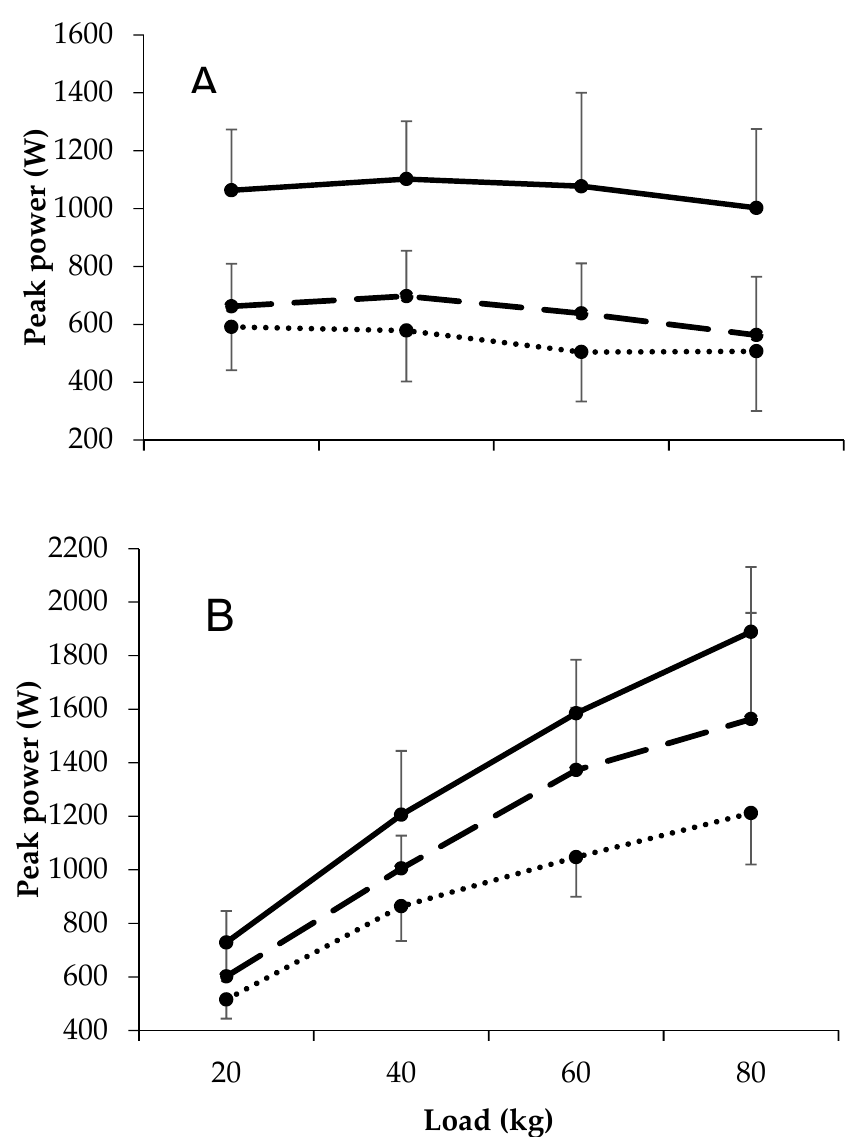
Figure 2. Load–power relationships in first team, academy, and scholarship players during the ( A ) bench press and ( B ) squat exercise.